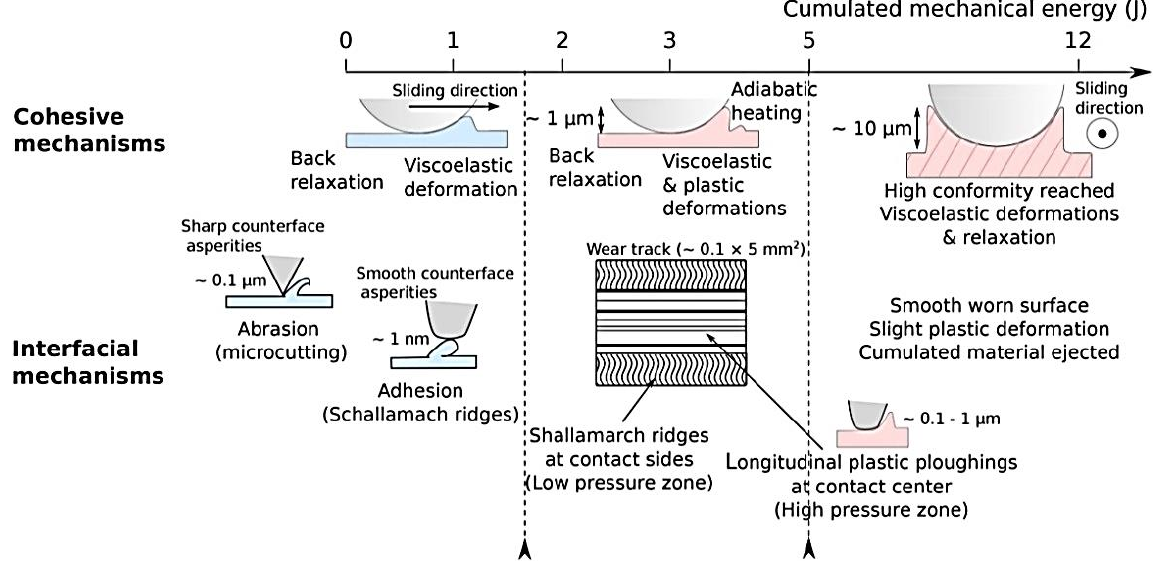
Figure 7. The cohesive and interfacial contact mechanisms as a function of the cumulated mechanical energy. Figure is reproduced with permission from reference [31].